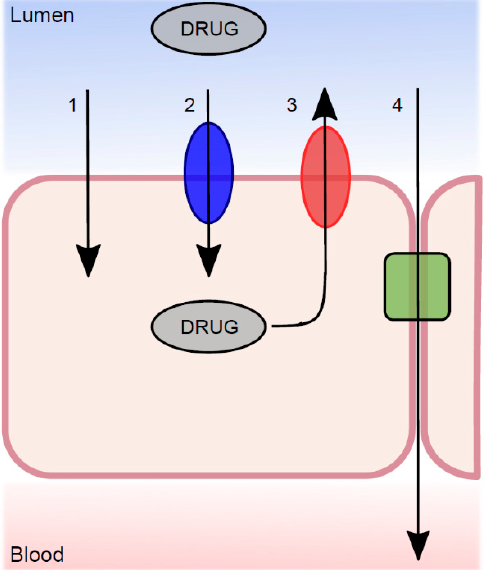
Figure 3. The transport mechanisms from the lumen across the intestinal epithelium, which determine the net permeability of a luminally dissolved drug molecule. ( 1 ) Passive transcellular diffusion; ( 2 ) absorptive carrier-mediated transport; ( 3 ) efflux carrier-mediated transport; and ( 4 ) passive paracellular diffusion.